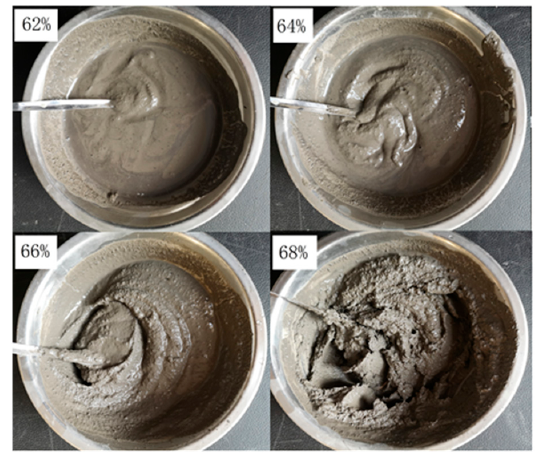
Figure 2. Slurry segregation